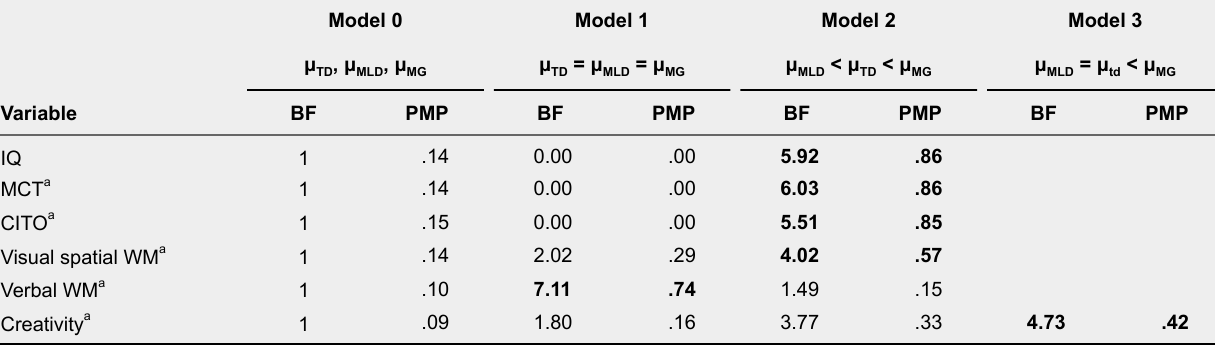
Comparison of Groups on Domain-General Variables, Corrected for